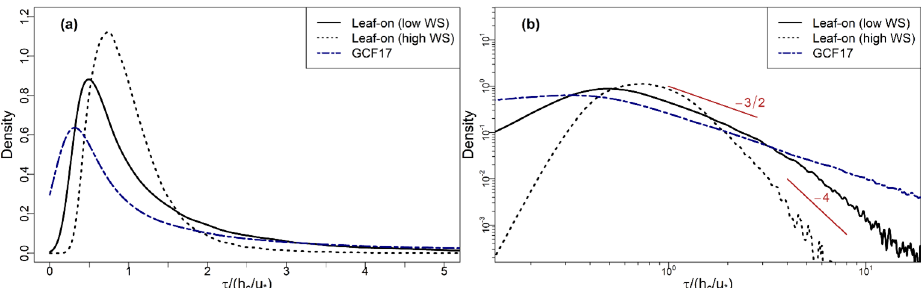
Figure 3. (a) Linear- and (b) logarithmic-scale PDFs of τ , as defined in Sect. 2.3, from BIFoR FACE during the lowest 50% (solid black) and highest 25% (black dashed) of wind speeds (WSs) of the leaf-on period. GCF17’s model in Eq. (1) is shown with the navy-blue dot–dash line. In panel (b) , slopes of − 3 / 2 and − 4 are shown for reference. The slope of − 3 / 2 is the power-law decay from GCF17 and Eq. (1), and − 4 is an arbitrary value to show the steeper decay of the right tail of the PDF of τ in strong winds. Values of τ normalised by the canopy turnover time h c /u ∗ (Sect.